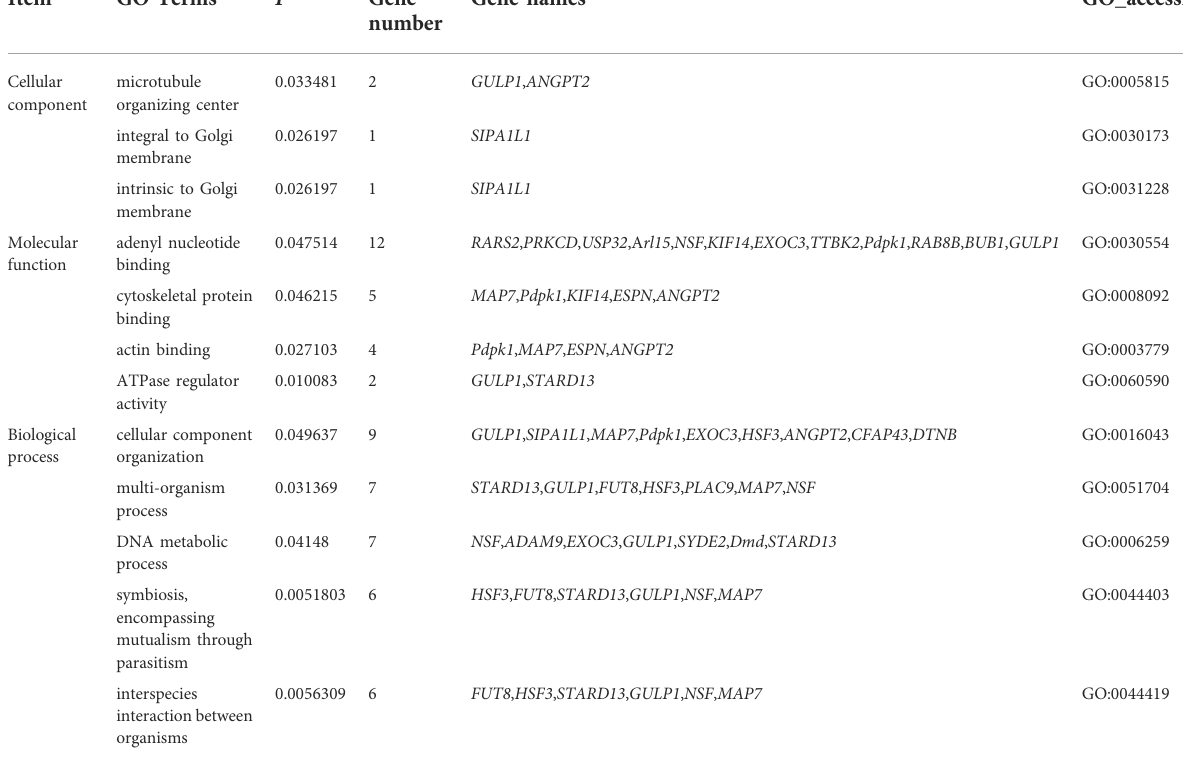
TABLE 4 GO enrichment analysis of circRNA host